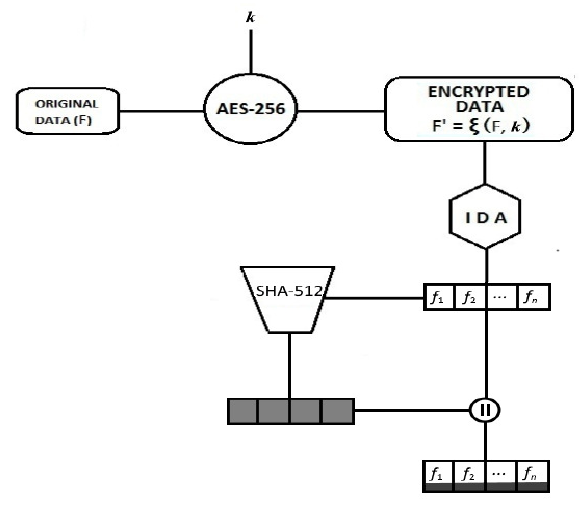
Figure 2. Encoding